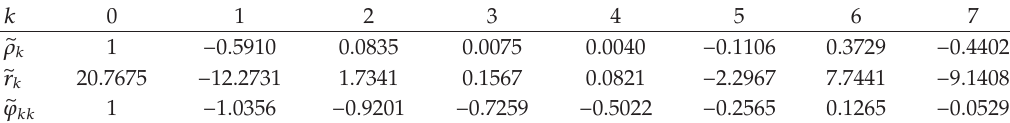
Table 3: Values of autocorrelation function, autocovariance function, and partial incidence degree